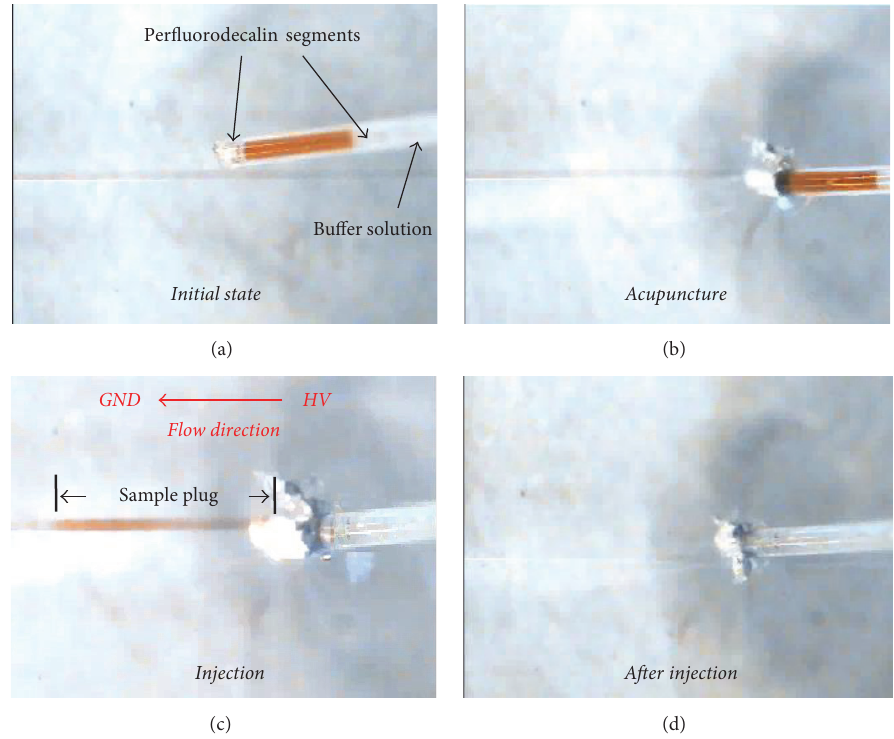
Figure 4: Consecutive CCD images recorded at the different stages of sample injection using the AICEI method from the top view. (a) Initial state, (b) acupuncture, (c) sample injection, and (d) after